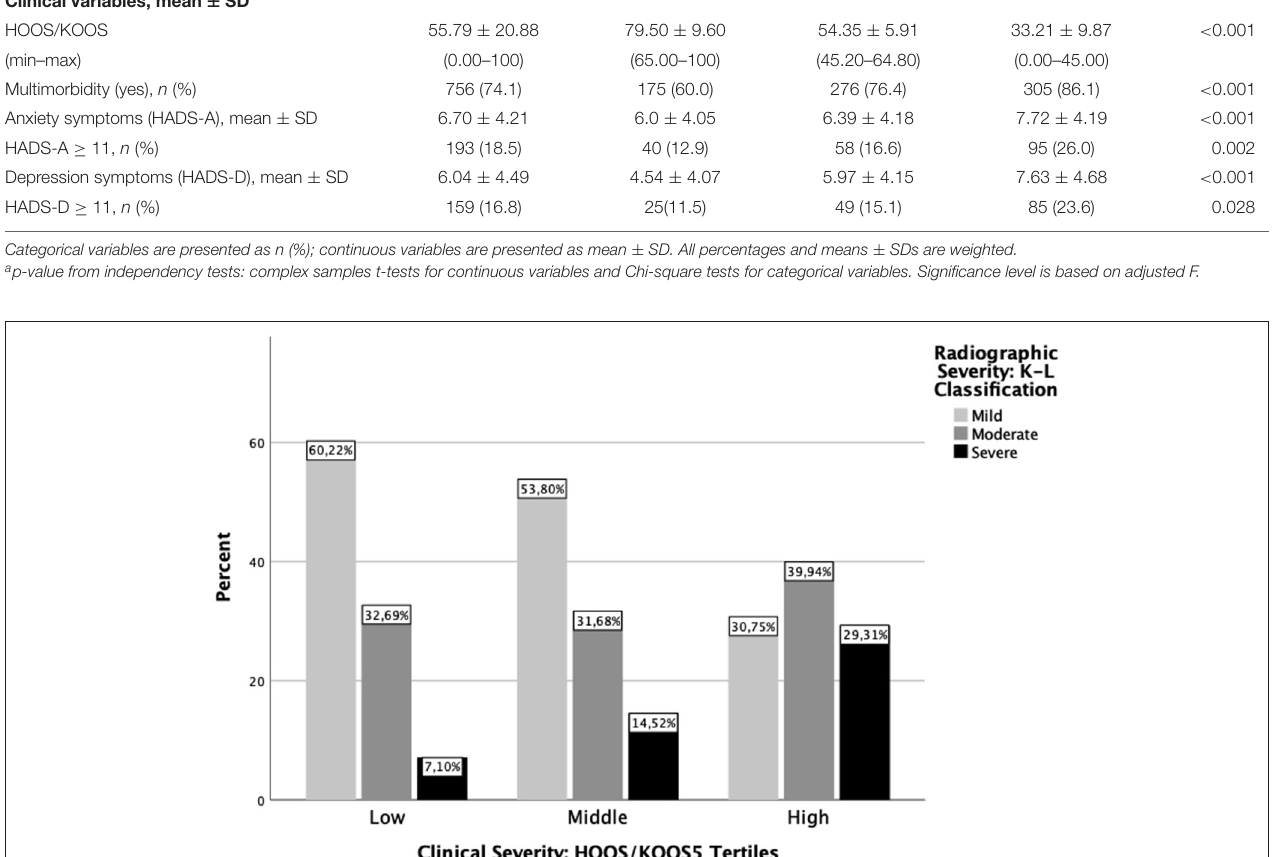
OR = 1.87; 95% CI: 1.06, 3.30; p = 0.003; obese: OR